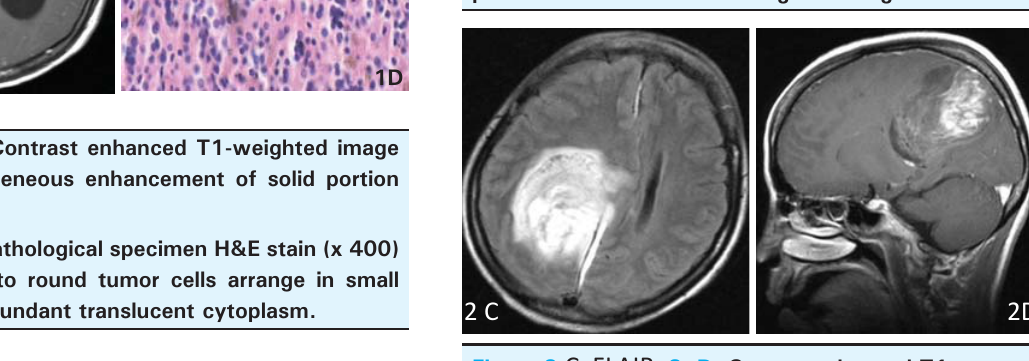
Figure 2. A. T1-weighted image shows low signal intensity space-occupying lesion with central area of ill-de fi ned high signal intensity resembling hemorrhage. 2. B. heterogeneous high signal intensity of the mass and adjacent dura (arrow) with mild perilesional edema on T2-weighted image.